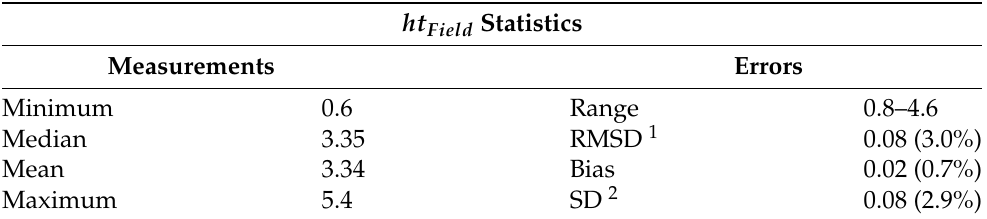
Figure 1. Location of the study area, highlighting tree identification and Ground Control Points (GCPs). Table 1. Summary of total heights ( ht ) measured in the young Eucalyptus stand and the associated measurement errors (all values in